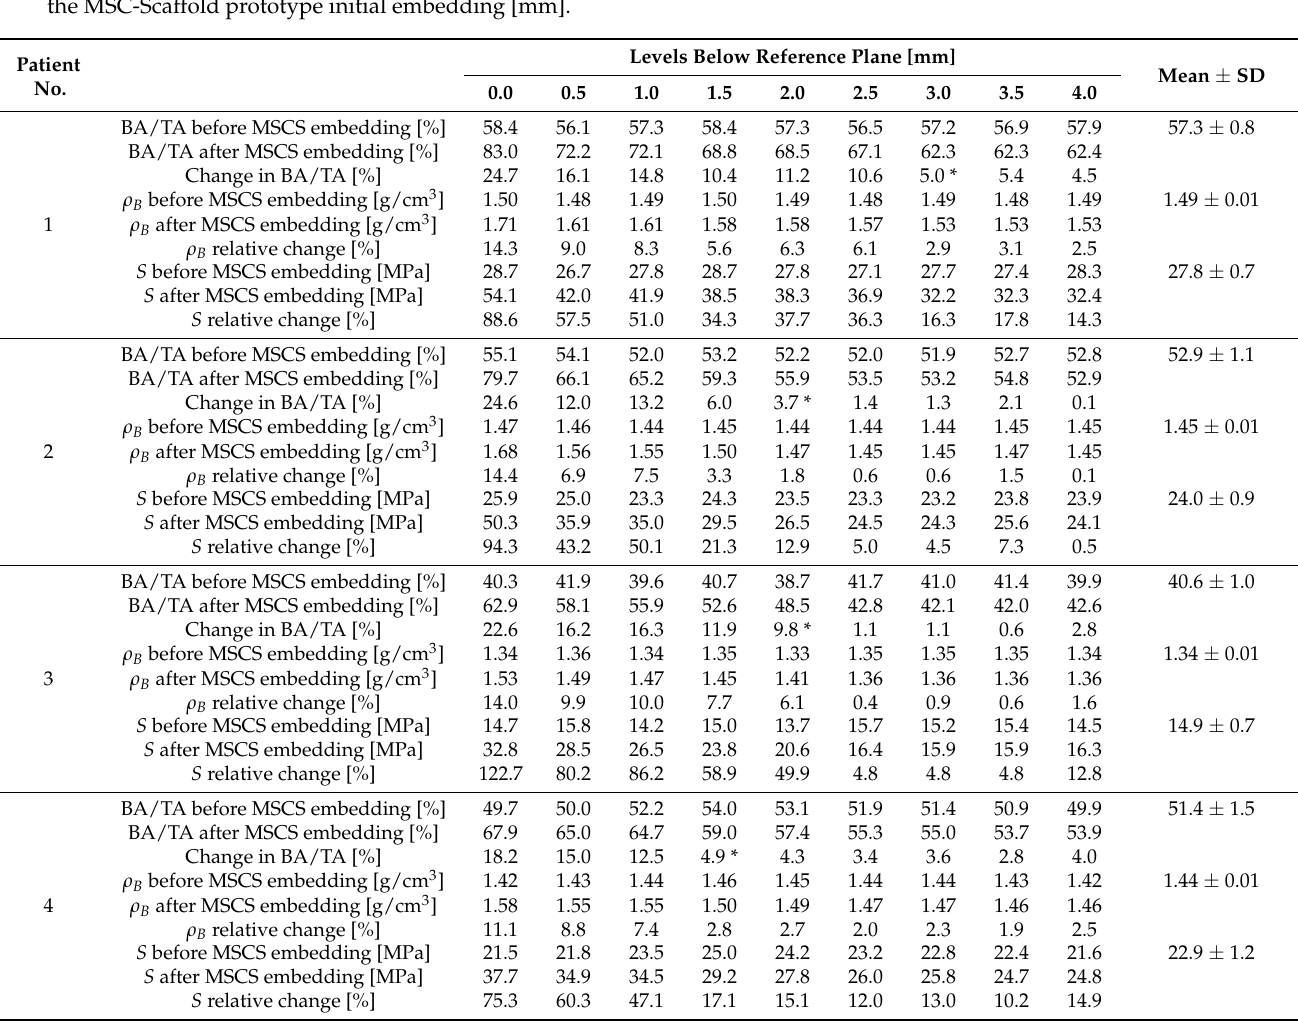
Table 2. Subchondral trabecular bone relative area (BA/TA) values in femoral heads from patients with OA measured in micro-CT before and after embedding of the MSC-Scaffold (MSCS), the percentage point changes in BA/TA values, the calculated corresponding subchondral trabecular bone densities ρ B , and subchondral trabecular bone compressive strength S, before and after embedding of the MSC-Scaffold, and changes in subchondral trabecular bone densities ρ B and subchondral trabecular bone compressive strength S ; * spatial extent of subchondral trabecular bone densification due to the MSC-Scaffold prototype initial embedding